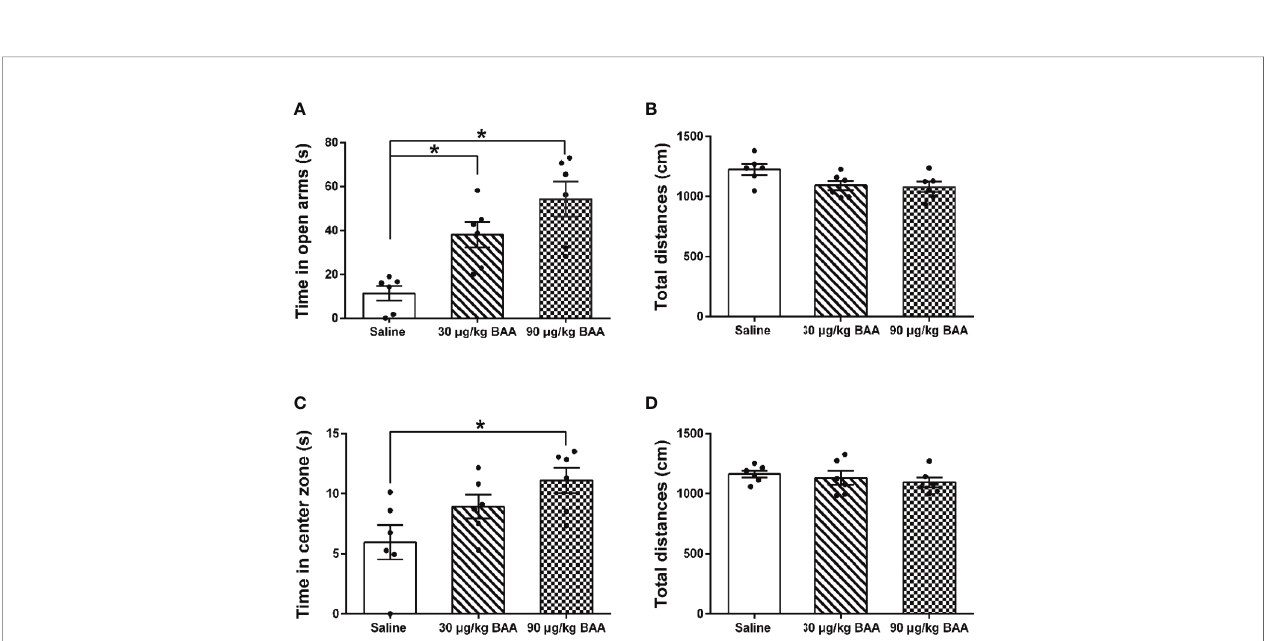
FIGURE 4 | The antianxiety effects of Bulleyaconitine A (BAA) on chronic visceral pain-anxiety comorbidity of 2,4,6-trinitrobenzene sulfonic acid + heterotypic intermittent chronic stress (TNBS+HeICS) rats. (A , C) The antianxiety effects of BAA on chronic visceral pain-anxiety comorbidity rats in the elevated plus maze (EPM) test and open fi eld test (OFT) (n = 6 each; one-way ANOVA; * P < 0.05). (B , D) BAA did not in fl uence the total distance whether in the EPM test or in the OFT. The data are presented as means ± standard error of means (SEM).